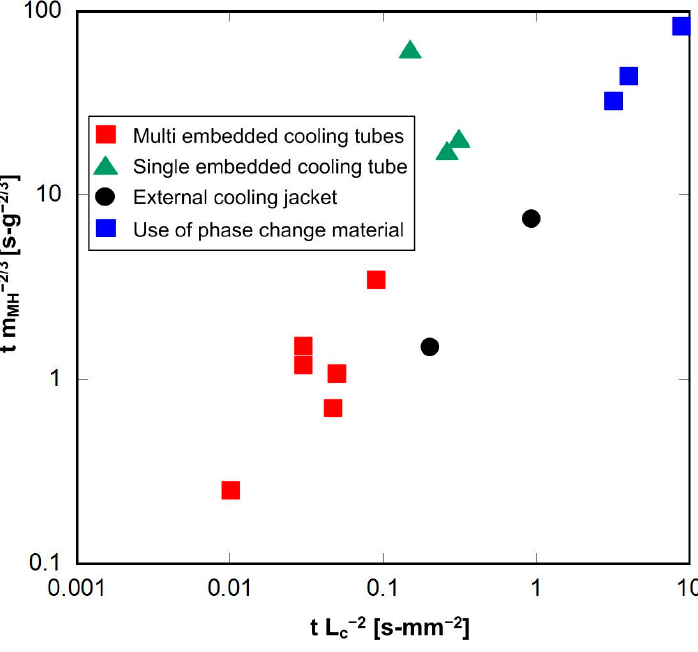
Figure 7. The metal hydride mass-based time vs. the characteristic length-based time.